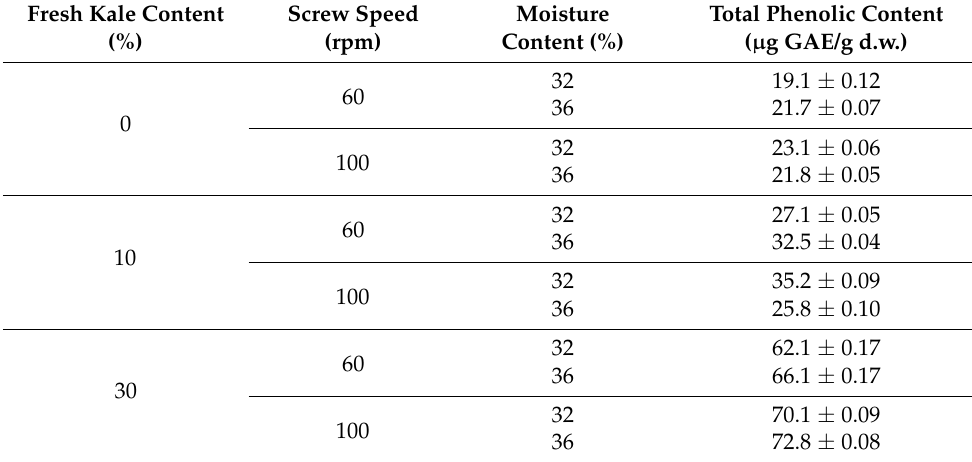
Table 3. Total content of polyphenolic compounds (TPC) in snack pellets enriched with fresh kale (n = 3, ±